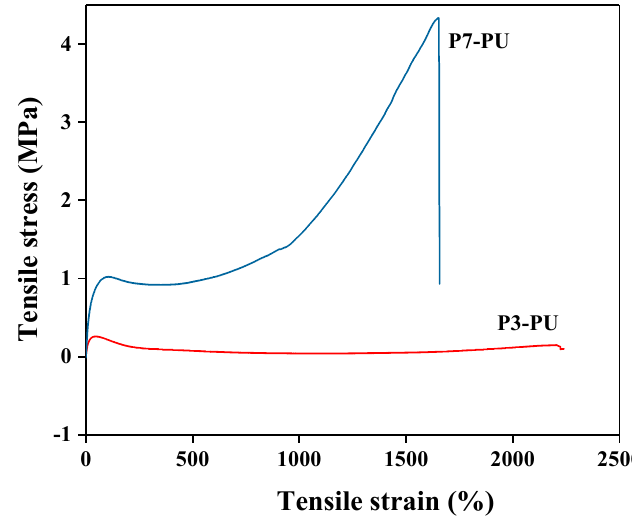
Figure 9. Stress-strain curves of P3-PU and P7-PU .